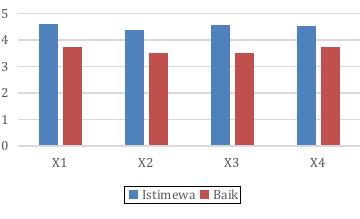
Figure 12. The chart bar of